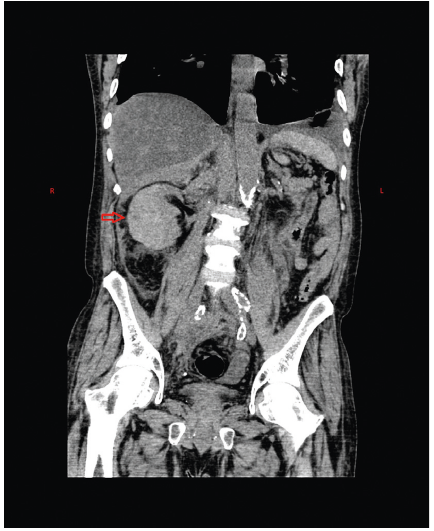
Figure 2: Coronal section of the noncontrast CT scan of the ab- domen showing an enlarged right kidney (marked in red arrow) suggesting a potential collection with or outside the renal